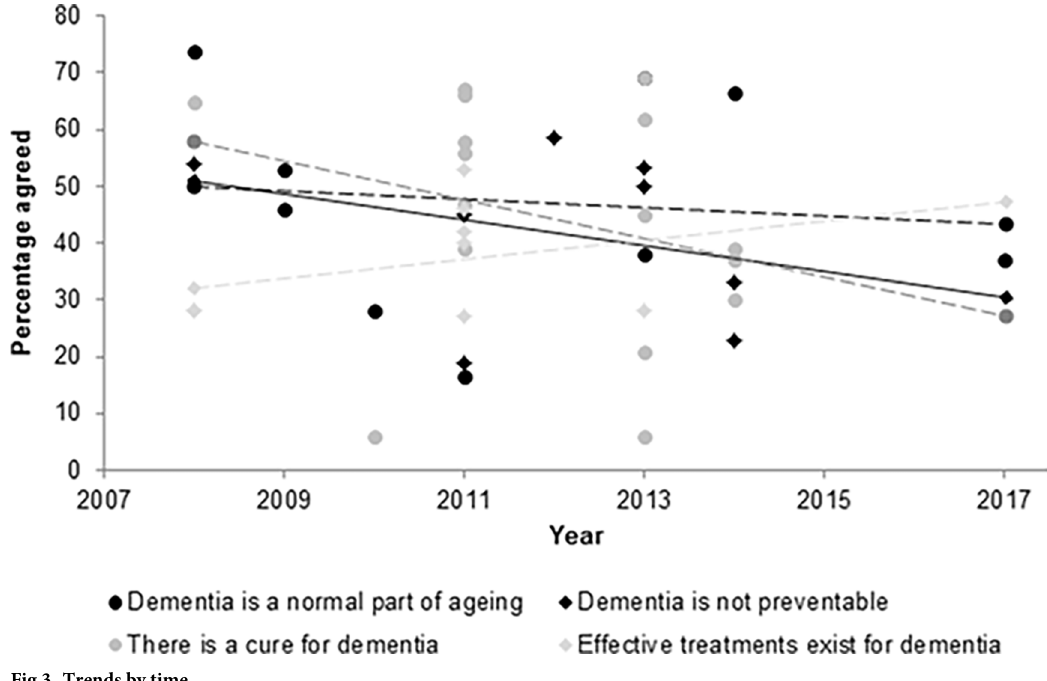
Fig 3. Trends by